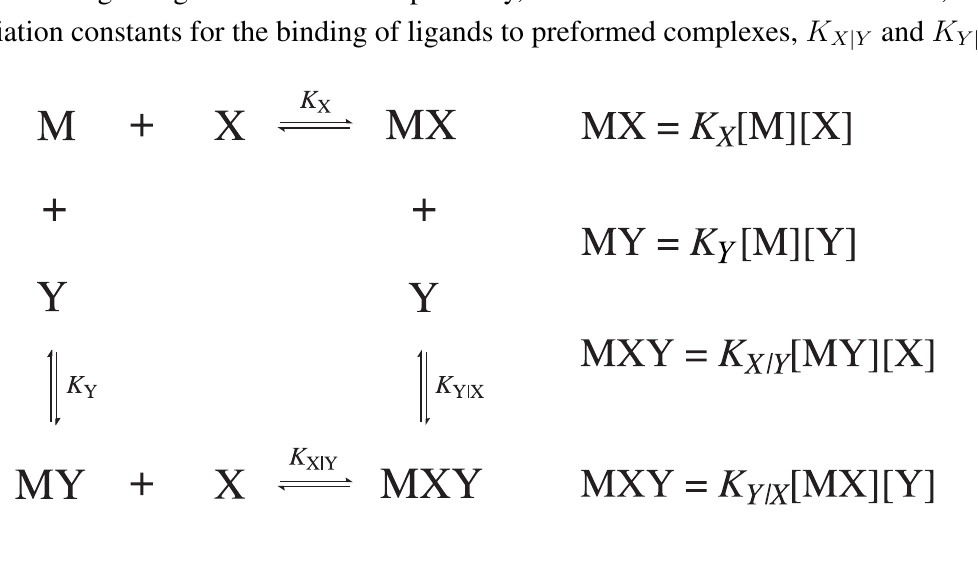
Figure 1. Reaction scheme for the binding of heterogeneous ligands, X and Y , to a macro- molecule, M , containing two binding sites. The stepwise association constants, K for the binding of ligands X and Y respectively, to free macromolecule are shown, as the association constants for the binding of ligands to preformed complexes, K